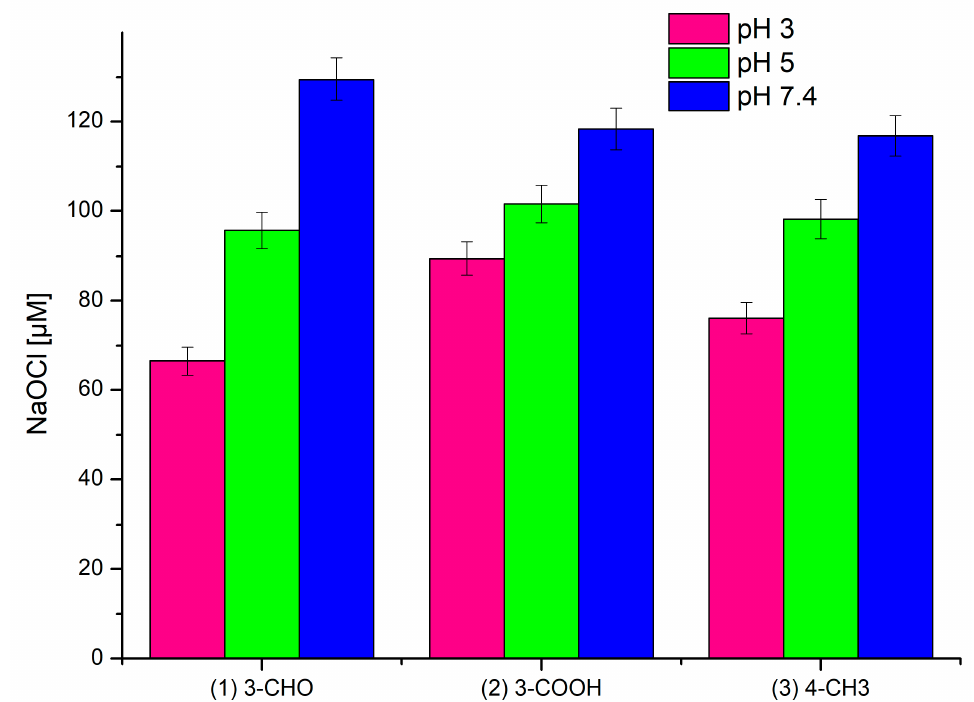
Figure 3. NaOCl concentration causing a 50% decrease in the fluorescence intensity of 150 μ M of probes 1 – 3 at various pH levels, λ Ex 289 ( λ Em 464 nm, 460 nm, and 450 nm, respectively), and a temperature of 25 °C.